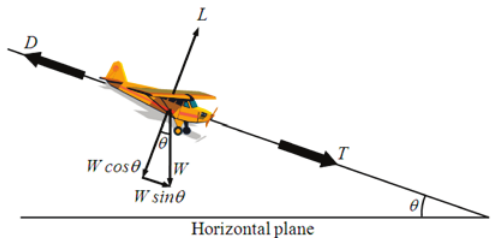
Fig. 5. Forces acting on the aircraft during descent [Note: T = thrust, D = drag, L = lift, W = weight of aircraft, θ = angle between the aircraft flight path to the horizontal plane]